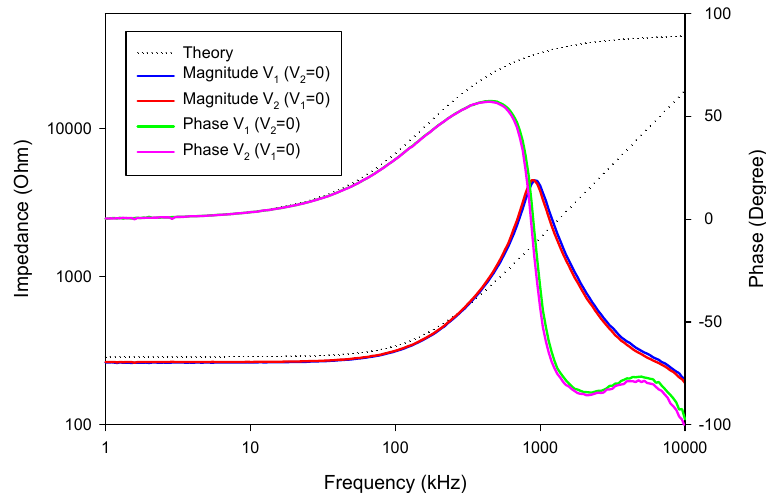
Figure 36. The experimental frequency responses of lossless L with different I B .